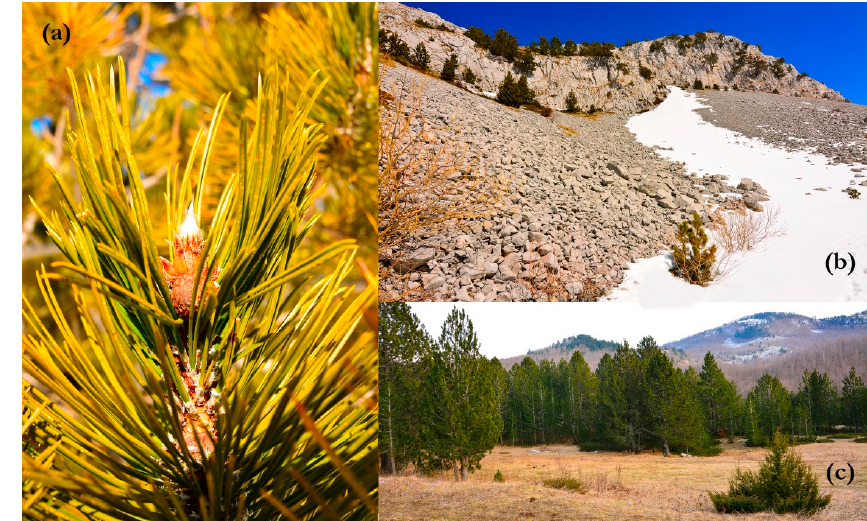
Figure 2. ( a ) Pinus heldreichii shoots with needles; trees growing at ( b ) Ku č i Mountains, Momonjevo (KMT), and ( c ) Ku č i Mountains, Ku č ka korita (KKO) sites. Climate at the study sites is characterised as a humid warm temperate climate type (Cf), which is represented by subtypes Cfsb, Cfs’’b and Cfb [22,23]. Summers are short, dry and chilly, and winters are cold and windy. At different study sites, the mean annual air temperature is between 1 ° C (at PRO) and 6 ° C (at ORJ). The mean daily summer maximum is between 7 and 11 ° C, and the mean daily winter minimum is between − 5 and 0 ° C. The absolute minimum is in winter at ca. − 30 ° C and the maximum is in summer, at ca. 30 ° C. The mean annual precipitation is highest at ORJ with ca. 3800 mm, and lowest at PRO with ca. 2000 mm. The rainfall reaches maximum in late autumn and early winter, while the minimum is during the summer months that is often followed by 40–70 day- long periods of droughts. The mean summer precipitation is 300 mm at ORJ and ca. 220 mm on other sites, making ca. 10% of the total annual precipitation [22]. The bedrock at the study sites is solid chalk limestone, which contains a small proportion of insoluble residues. In general, soils are poorly developed, very water porous, skeletal leptosols (rendzina), having only A horizon, characterized by accumulation of humus (A-R profile). According to the classification of texture, the soil is a sandy loam and the structure is powdery. Soil is faintly differentiated down in the soil profile. Soil is rich in humus content (10–25%), poor in calcium- carbonate and has a weak acid reaction (pH ca. 6). On more flat terrains, leptosol develops into the leptic cambisol, which contains initial B horizon. Brown B horizon improves the water retention capacity of soil [20,24]. 2.2. Experimental Design and Sampling At the sampling sites, stands of P. heldreichii were healthy-looking (Figure 2a). An exception was the KKN site, where trees were damaged by Tomicus sp. bark beetles, resulting in discolouration and fungal infection of needles. At all sites, the shoot dieback was occasional, but with higher rates at the KKN site. Sampling was carried out in May 2015, i.e., before the beginning of the growing season. At each site, experimental design included sampling of five twigs with needles from five different trees. Hence, at each site, five mature P. heldreichii trees situated at a distance of ca. 50 m from each other were selected and five twigs of up to 15 cm long and up to 2 m from the ground were sampled from different parts of the crown using secateurs. This sampling approach was used in order (i) to get a joint representative sample per each site (all samples per site were amplified with the same barcode, see below); (ii) to compare fungal communities among different sites, but not within the same site. Collected twigs were placed in plastic bags and transported to the laboratory.